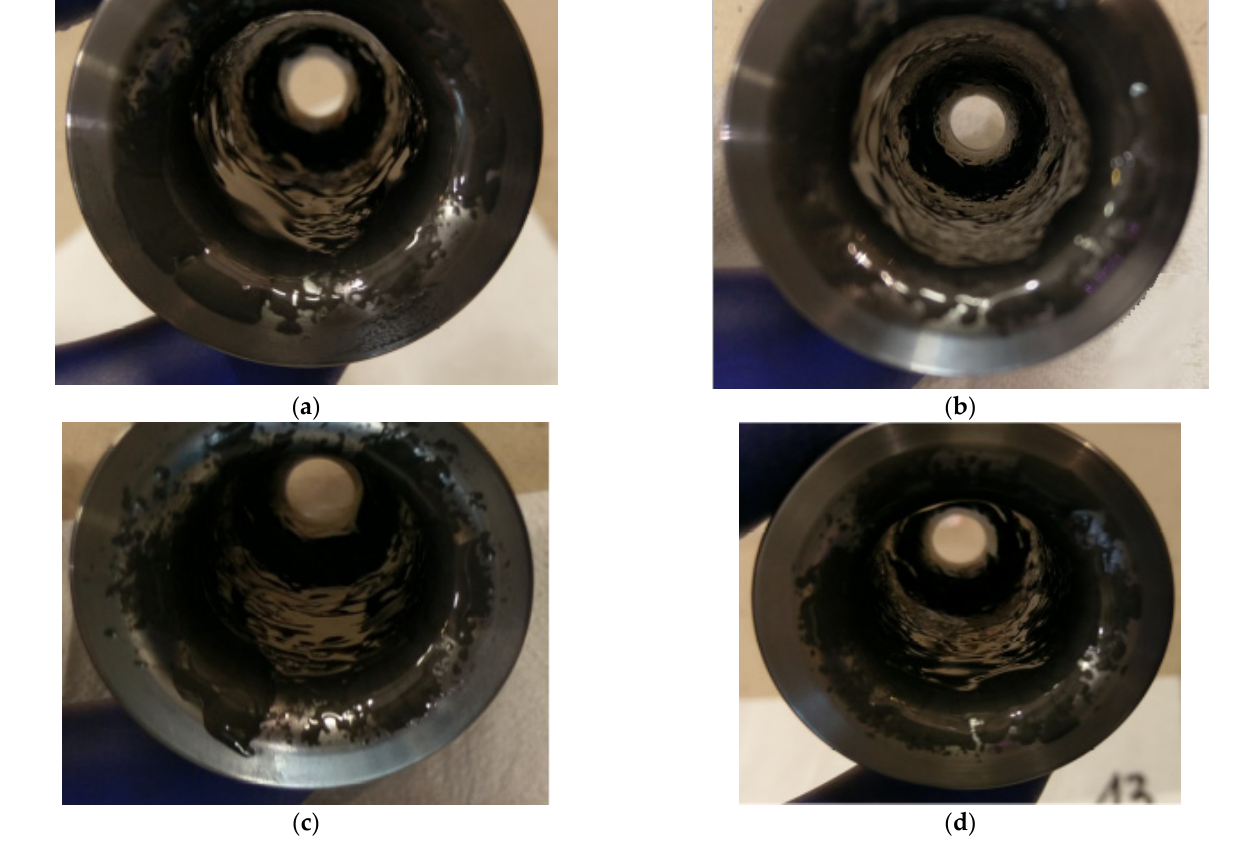
Figure 8. Lubricant fed inside the die for particular test parameters: ( a ) variant 1; ( b ) variant 3; ( c ) variant 2; ( d ) variant 4.